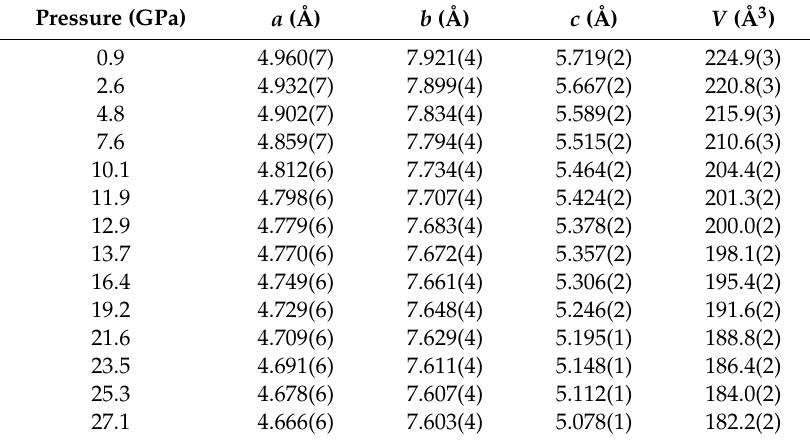
Table 1. Aragonite unit-cell parameters and volume up to 27.1